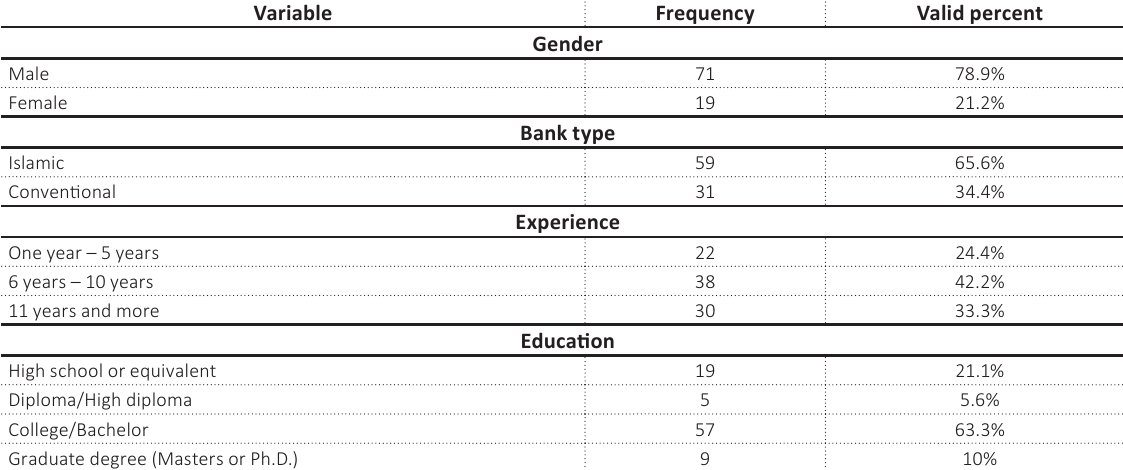
Table 1. Respondent